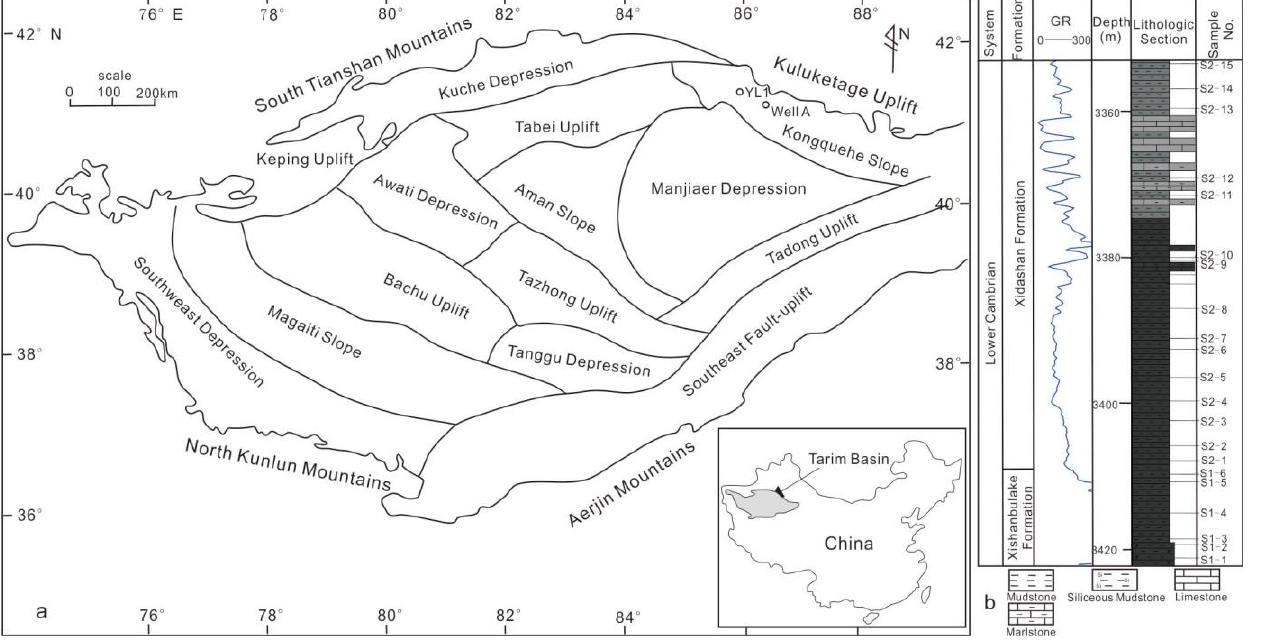
Figure 1. Location map of the study area. ( a ) Geological map of Tarim Basin in China. Modified from Gao and Fan (2015) [13]. ( b ) Details of Well A, including stratigraphy, lithology, and sample locations.